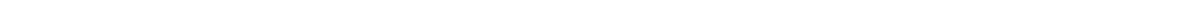
Figure 3 | IFI16 is required for the DNA-induced activation of STING and IRF3. ( a ) Confocal analysis of IFI16 þ / þ and IFI16 (cid:2) / (cid:2) HaCaT cells that were mock transfected or transfected for 1h with 5 m gml (cid:2) 1 HT DNA. Cells were stained for endogenous IFI16 (red) and STING (green). DNA is visualized with DAPI (blue). ( b ) Cells as in ( a ) were observed by confocal microscopy and scored for STING clustering. At least 200 cells were counted per